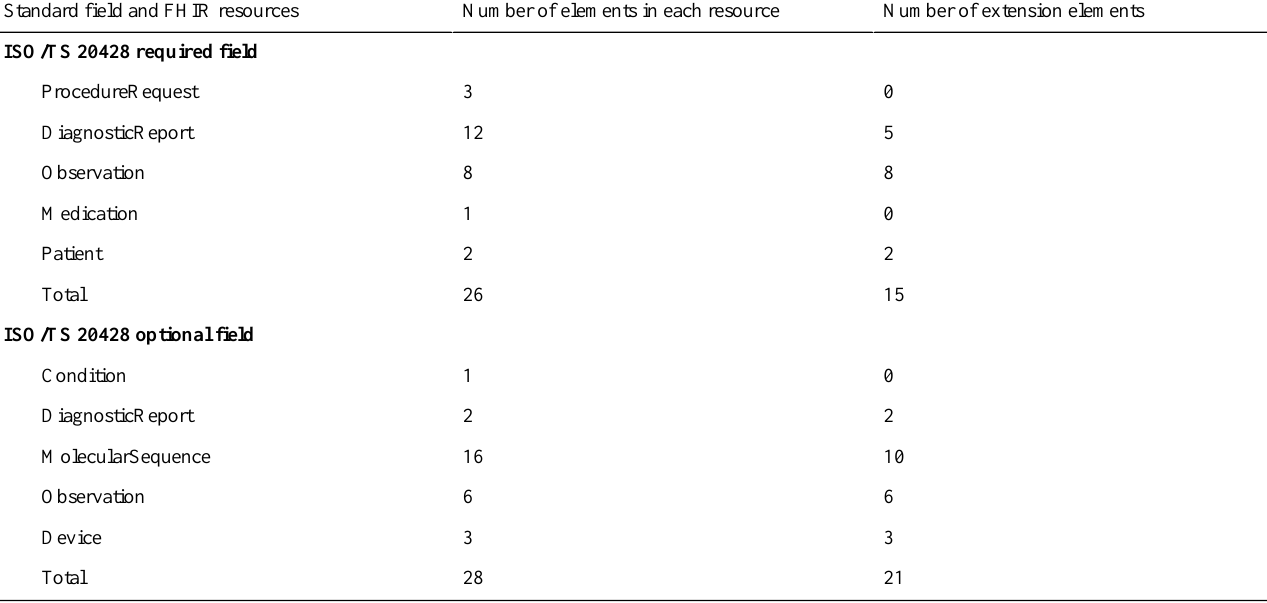
Table 2. Number of data elements per Fast Healthcare Interoperability Resources (FHIR) Genomics resource mapped by the International Organization for Standardization Technical Specification (ISO/TS) 20428